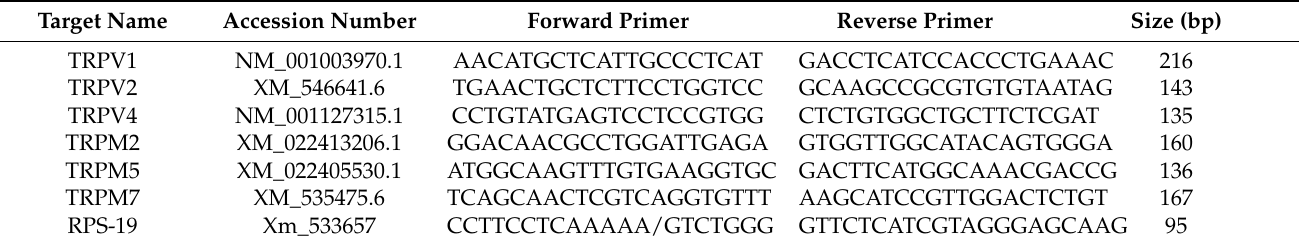
Table 1. Primer sequences for real time PCR of selected canine TRP ion channels. RPS-19 was used as a normalization gene. Target